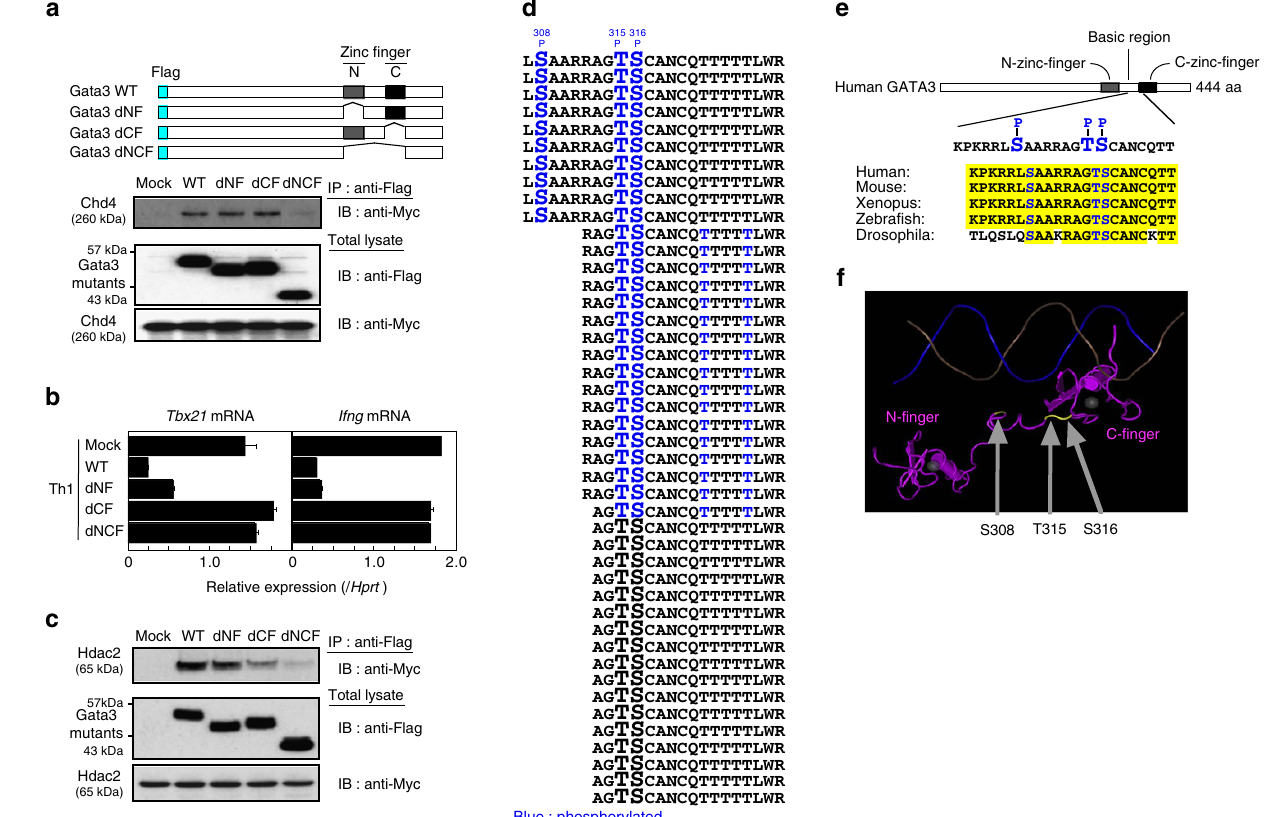
Figure 1 | Identification of Gata3 phosphorylation in the C-terminal zinc finger. ( a ) Schematic representations of the Flag-tagged Gata3 WTor deletion mutants are shown (top panel). Flag-tagged Gata3 WT, dNF, dCF or dNCF plasmid constructs were transfected with Myc-tagged Chd4 into 293T cells. Two days later, the amount of Myc-tagged Chd4 associated with the Flag-tagged WTor mutant Gata3 was assessed by immunoprecipitation (IP) followed by immunoblotting (IB) (middle panel). Total lysates were also subjected to IB in parallel (lower panel). ( b ) Naive CD4 T cells were stimulated under Th1 conditions and then infected with a retrovirus vector carrying WTor mutant Gata3 cDNA. Three days later, the retrovirus-infected GFP-expressing cells were purified and the levels of mRNA of Tbx21 and Ifng were measured by RT-qPCR. The relative expression (/ Hprt ) is shown with s.d.’s. ( c ) The amount of Myc-tagged Hdac2 associated with Flag-tagged Gata3 mutants were assessed as in Fig. 1a. ( d ) D10G4.1 cells were infected with a lentivirus encoding Flag-Gata3 and then the immunopurified Gata3 was subjected to a LC-MS/MS analysis to assess posttranslational modifications. All Gata3 peptides including Thr315 and Ser316 detected by our mass spectrometry analysis are shown. Blue characters indicate phosphorylated amino acids. ( e ) The phosphorylated residues of Gata3 in the linker region of tandem zinc fingers are highly conserved from Drosophila to human. ( f ) The 3D structure of Gata3 zinc fingers bound to DNA, including the novel phosphorylation sites (Ser308, Thr315 and Ser316) determined using the Molecular Modeling Database (MMDB ID; 105495) 30 , was drawn using the Cn3D software programme. The phosphorylated Ser/Thr residues are highlighted in yellow. Four ( b ) and three ( a , c ) independent experiments were performed with similar